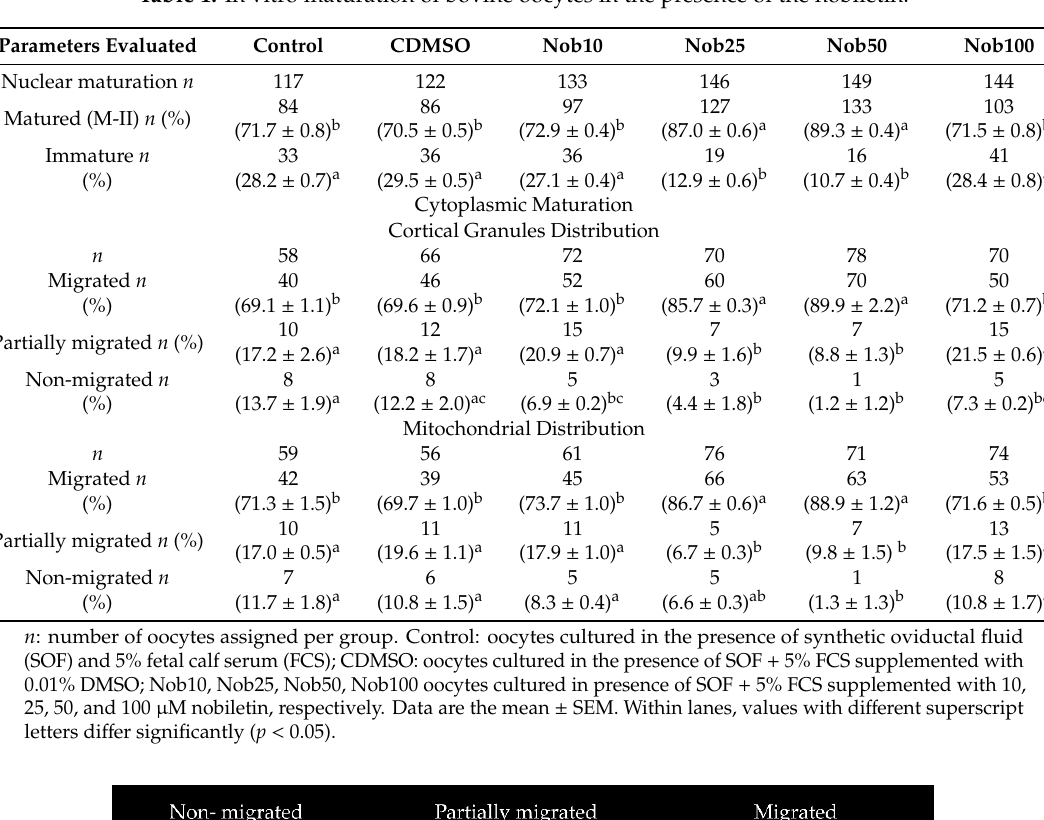
Table 1. In vitro maturation of bovine oocytes in the presence of the nobiletin.